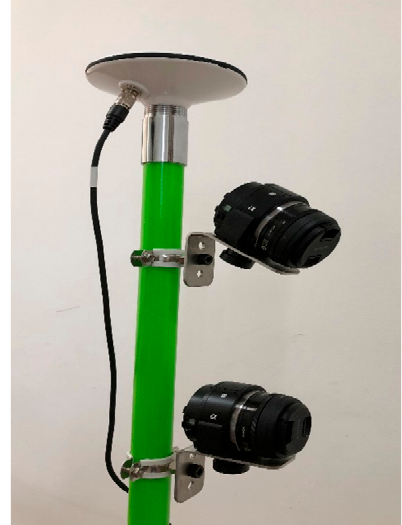
Figure 4. Two CCD lens placement details.